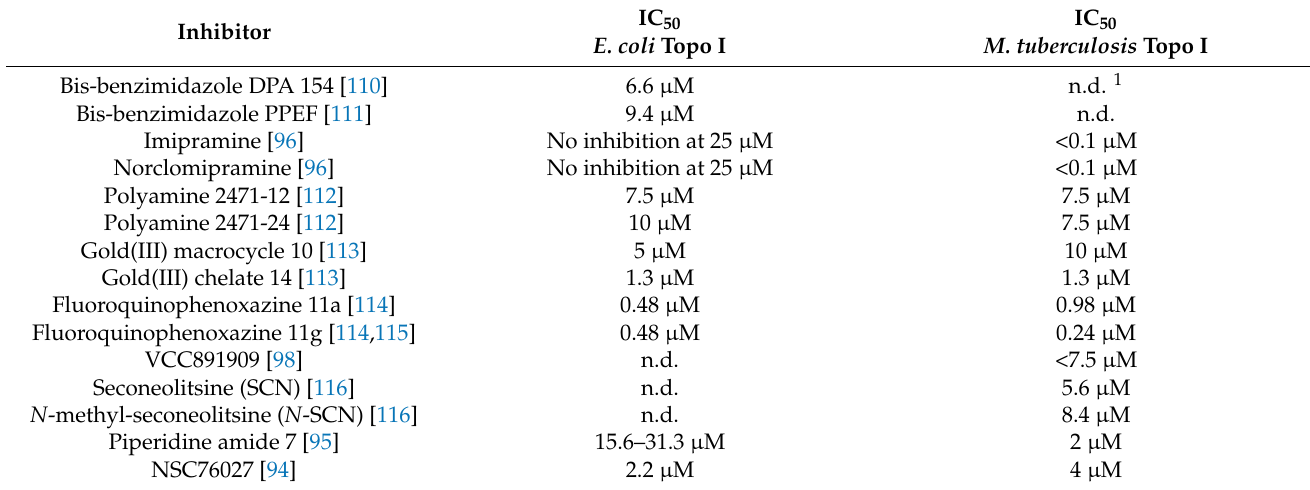
Table 1. Recently described small molecule inhibitors of bacterial topoisomerase I